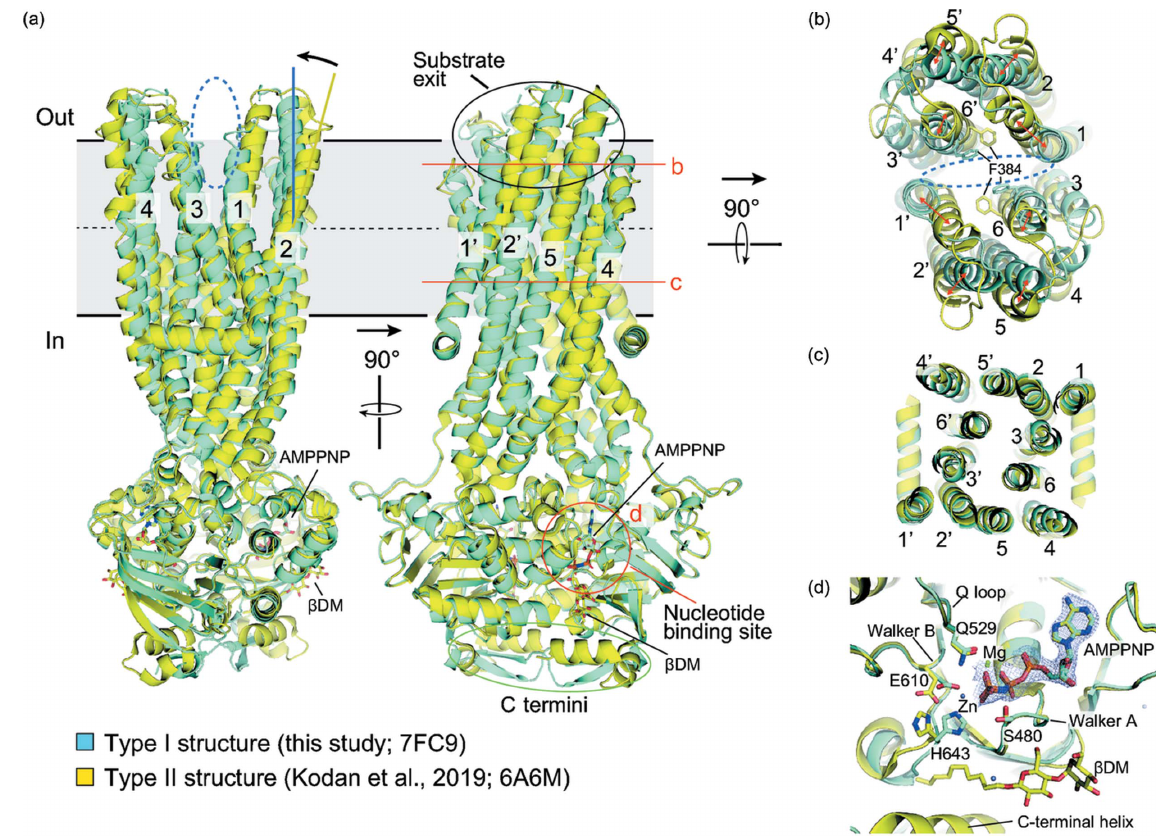
Figure 3 Structural comparison of the type I and type II OF crystal structures of CmABCB1 QTA . ( a ) Structure alignment of the two types of crystal structures. Black solid lines indicate the boundaries of the lipid bilayer. Black dashed lines indicate the middle of the lipid bilayer. Red solid lines and a red ellipse indicate regions enlarged in ( b ), ( c ), and ( d ). Ellipses with blue dashed lines in ( a ) and ( b ) indicate the cleft of the substrate exit. ( b ) Displacement of the TM helices at the outer leaflet region constituting the substrate exit. ( c ) The inner leaflet part of the TM helices exhibits little difference. ( d ) Nucleotide- binding sites of the two structures. The (cid:4) DM molecule belongs to the type II structure and the Zn ion belongs to the type I structure. The blue mesh shows a 2 F o (cid:3) F c electron-density map of AMPPNP in the type I structure, contoured at the 1.5 (cid:3)